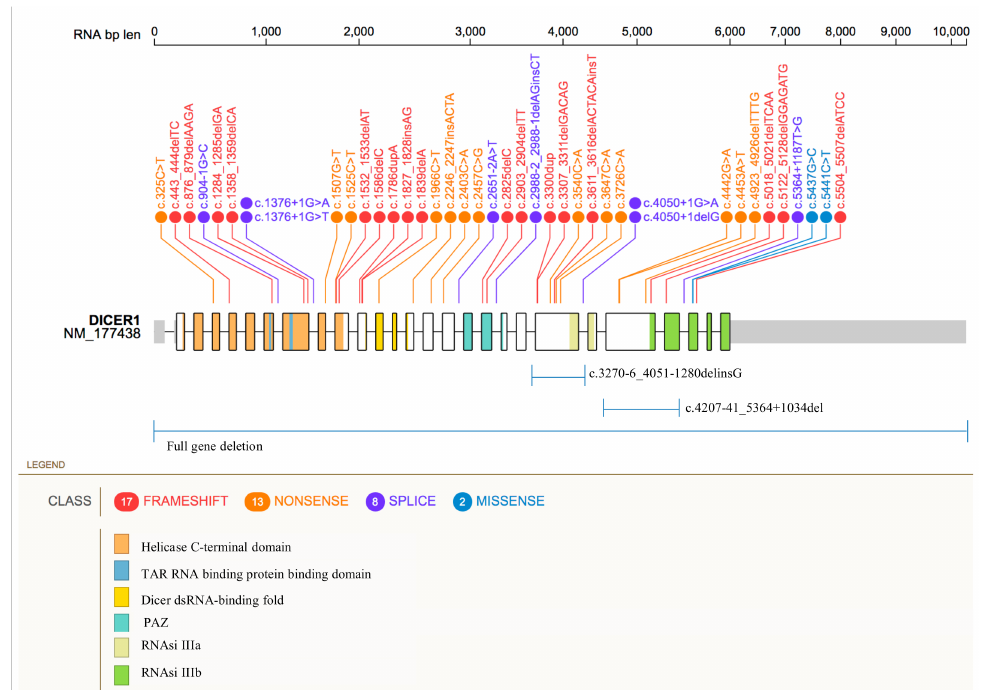
Figure 1. Distribution of DICER1 germline pathogenic variants. Figure 1 shows the location of the genetic variants along the DICER1 gene. SNPs and indels mutations are reported as frameshift (red), nonsense (orange), splice-site (purple), and missense (blue) variants. Large deletions are shown below. Protein domains are represented by colored areas.